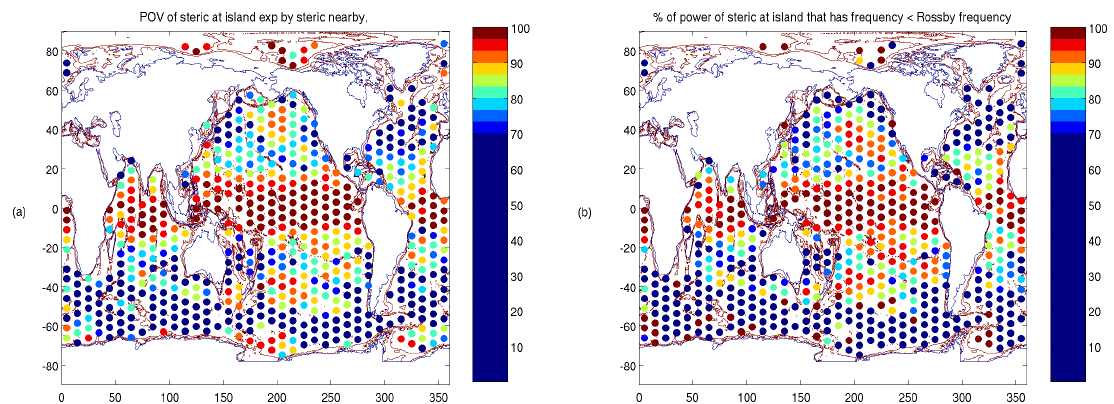
Fig. 8. (a) Percentage of variance of φ at “control island” explained by φ in a 2 . 5 ◦ neighbouring ring. (b) Percentage of the power spectrum in φ at the “control island” that has frequency lower than the Rossby frequency at that location. Note change of scale from earlier maps.